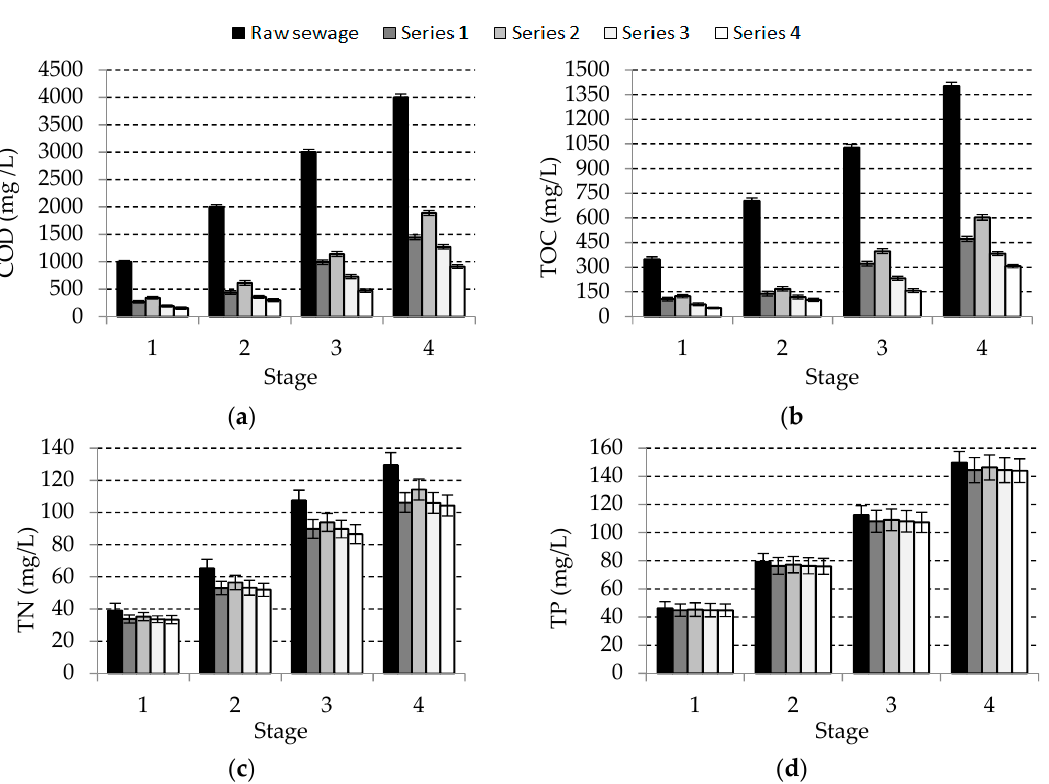
Figure 3. Concentrations of analyzed parameters in the effluent ( a ) COD, ( b ) TOC, ( c ) TN and ( d ) TP.